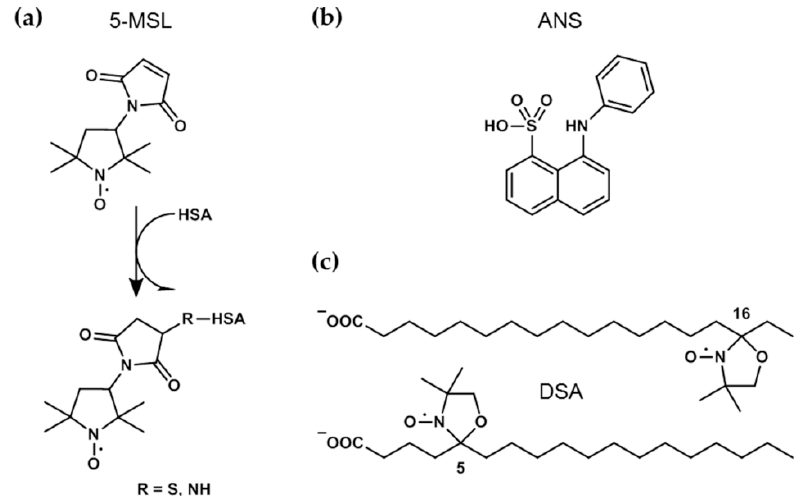
Table 1. Results from PROPKA 3.0 calculations.